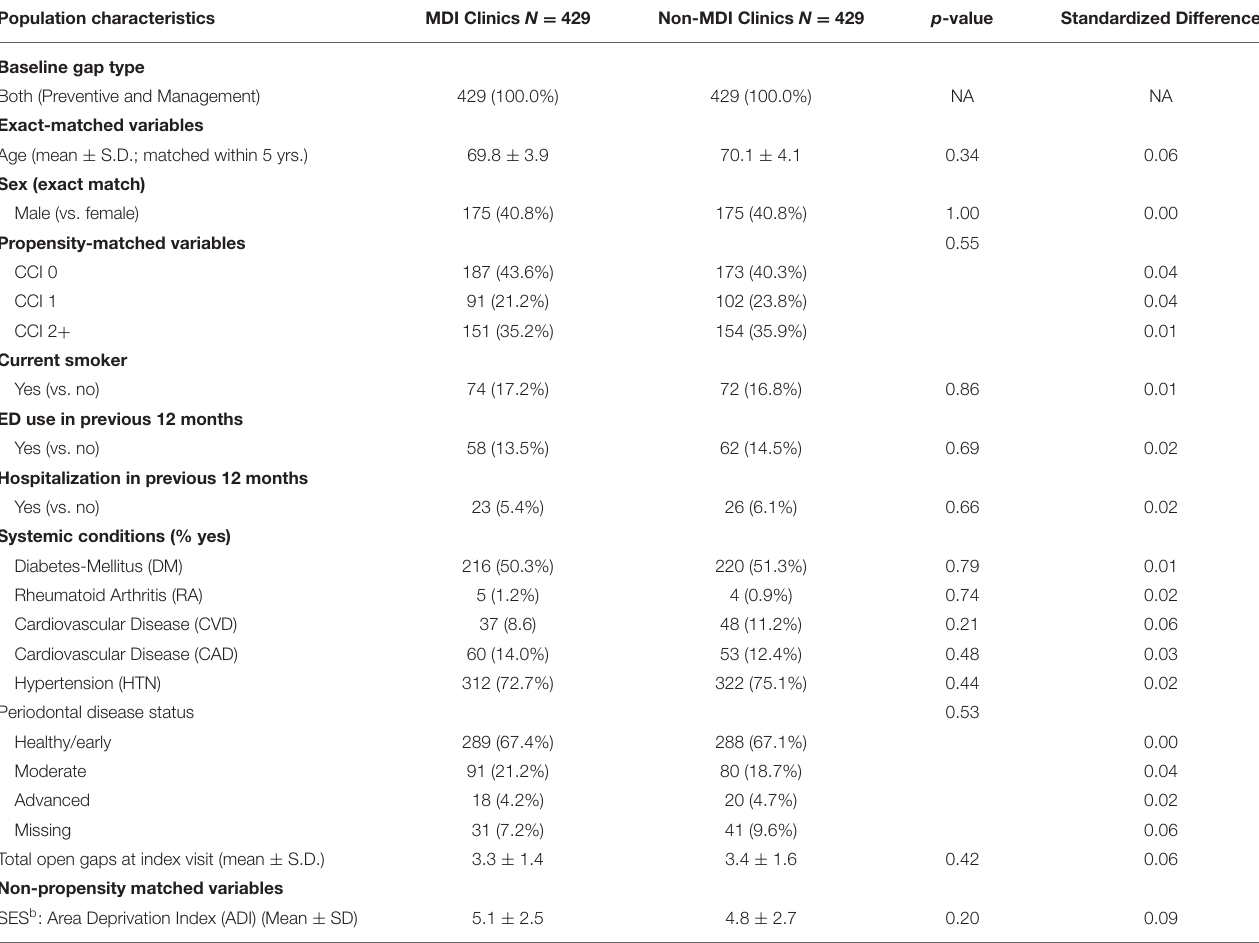
TABLE 1.3 | Population Characteristics: Both Gaps.